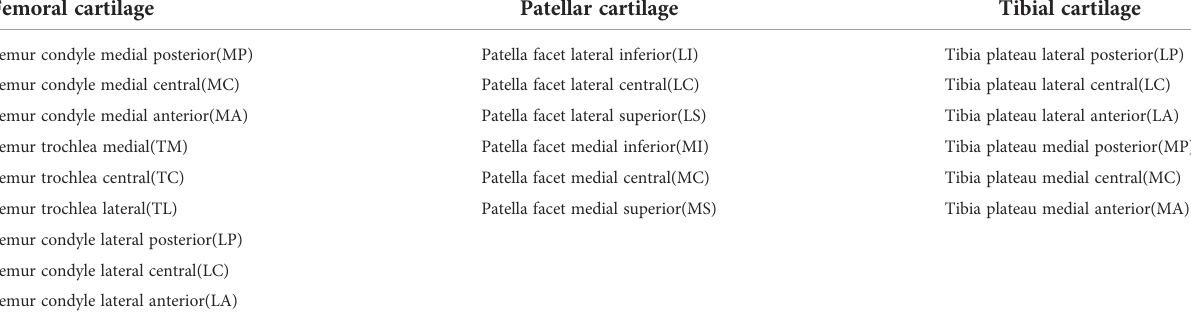
TABLE 1 21 subregions of knee articular cartilage automatically segmented by KneeCaP software. Femoral cartilage Patellar cartilage Tibial cartilage Femur condyle medial